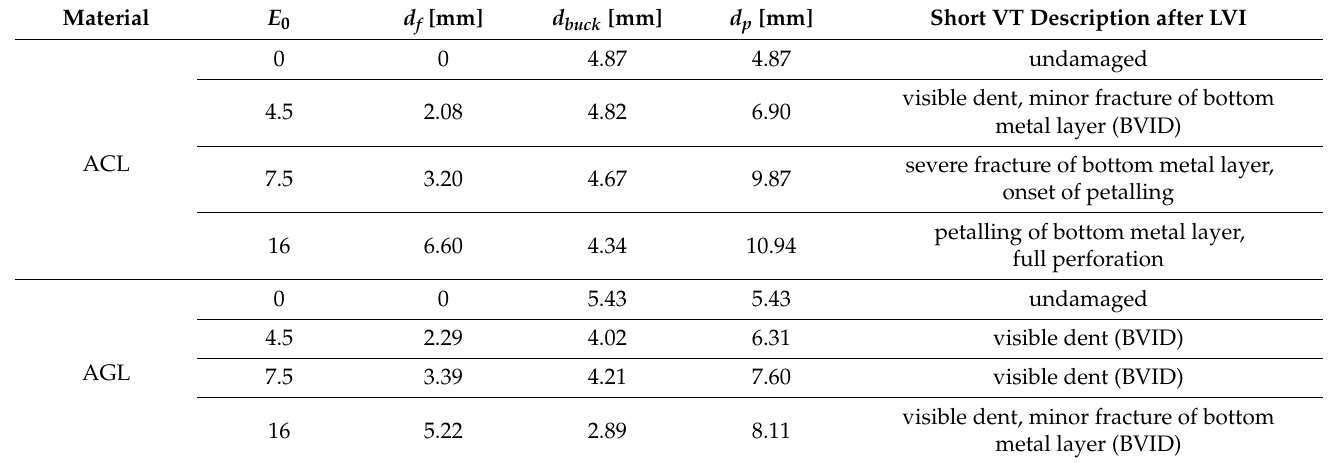
Table 2. Deformation parameters of ACL and AGL laminates caused by combined impact and